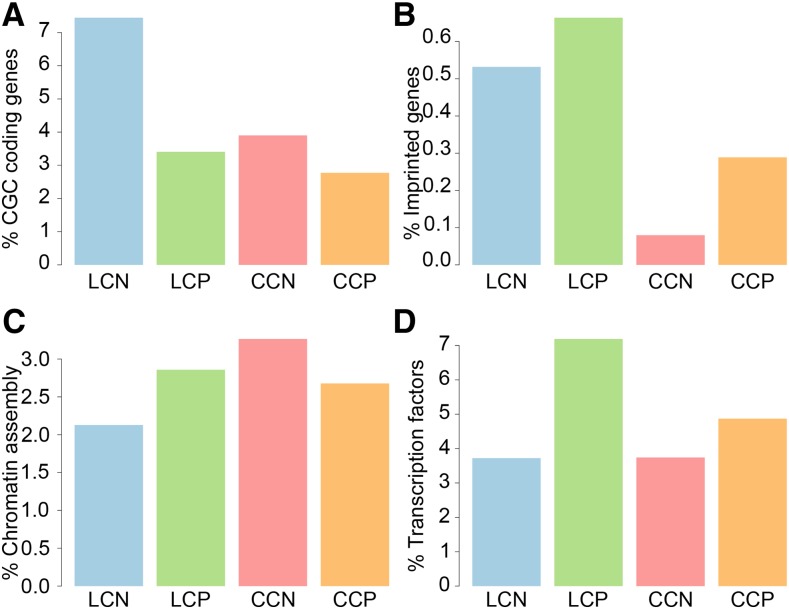
Enrichment of gene classes within specific subset of coding/lncRNA and coding/coding pairs showing positive or negative correlation in majority of cancer types A) Cancer Gene Census genes B) Imprinted genes C) Genes involved in chromatin assembly D) Transcription factors. LCN stands for lncRNA/coding negatively correlated, LCP is lncRNA/coding positively correlated set, CCN is coding/coding negatively correlated set and CCP is coding/coding positively correlated set.